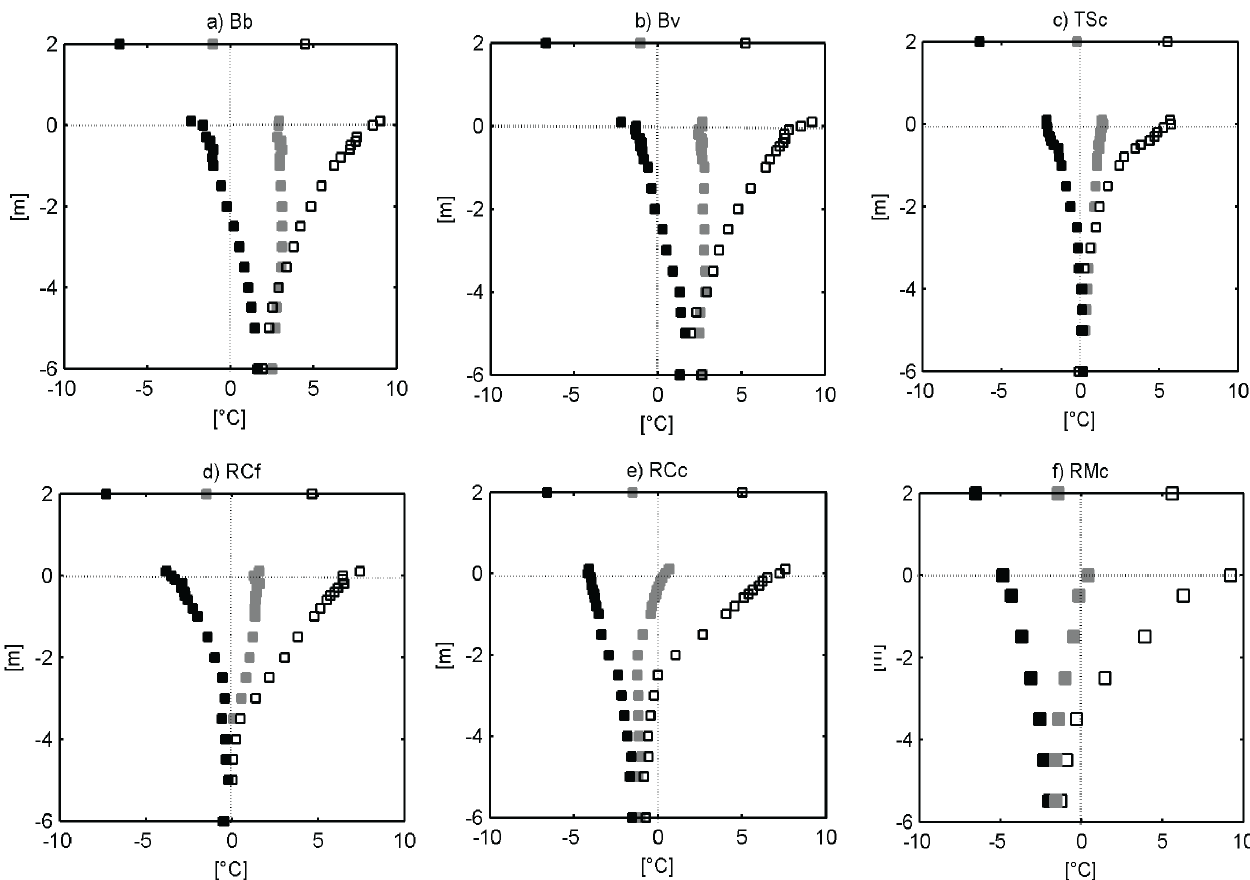
Fig. 7. Eight-year mean annual (grey), mean summer (white) and mean winter temperatures (black) for each borehole and each depth. In addition, air temperature (taken from the micrometeorological station at rock glacier Murt`el) and the individual mean GST at each borehole site are included.